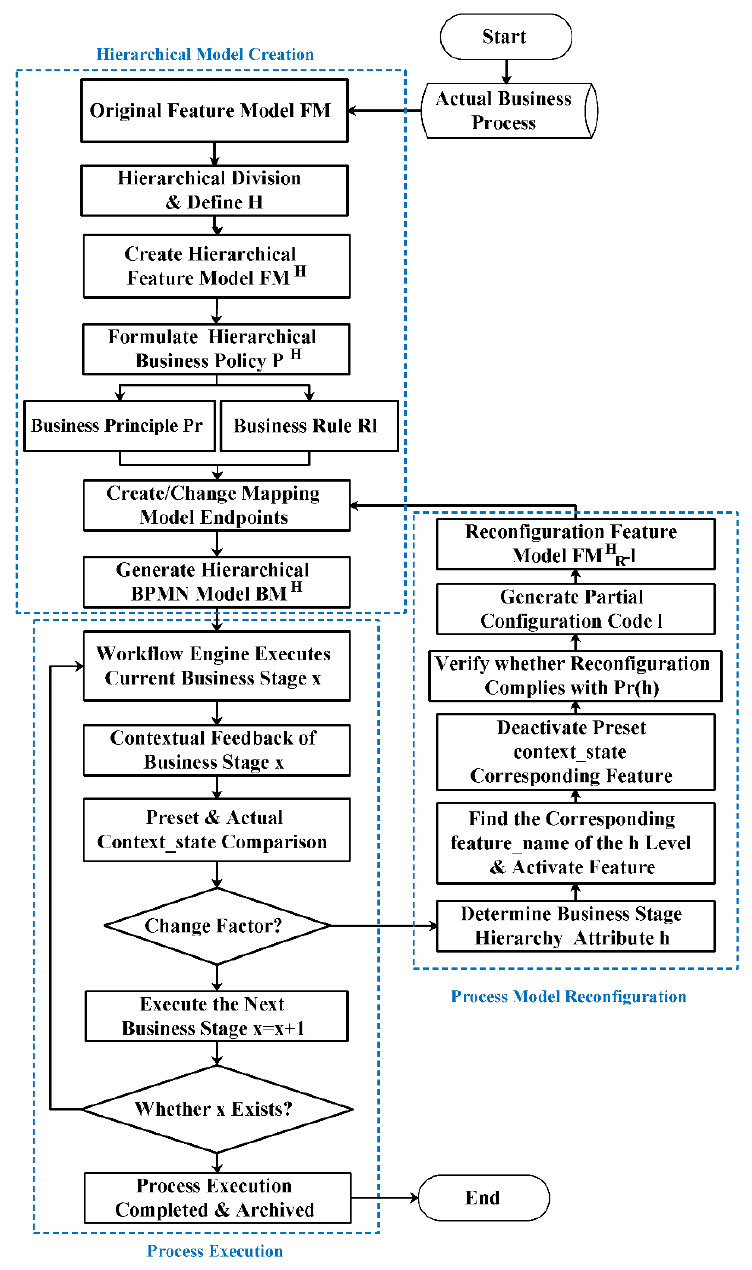
Figure 8. Hierarchical process model management mechanism.